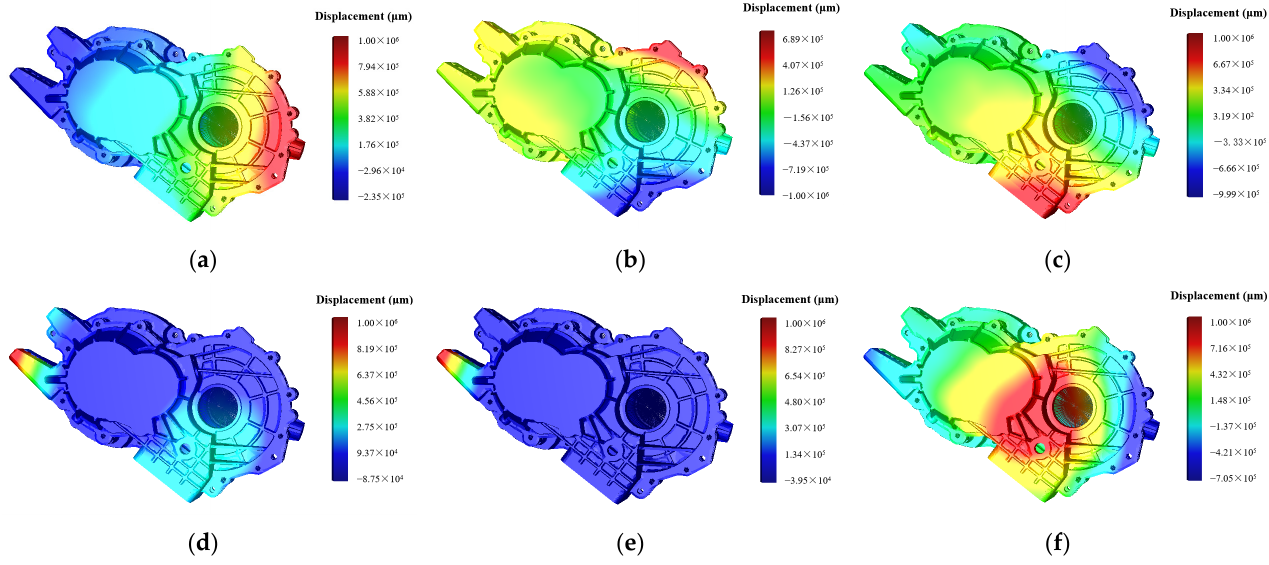
Figure 11. Modal shapes of the transmission housing under different frequencies with constraint: ( a ) 834 Hz; ( b ) 840 Hz; ( c ) 1752 Hz; ( d ) 2121 Hz; ( e ) 2524 Hz; ( f ) 2588 Hz. Different torques of 90, 75, and 60 Nm and three working conditions with the same torque of 60 Nm, and different speeds of 2400, 2700, and 3000 rpm were selected to solve the simulation model and were compared with the test data. The results are shown in Figures 12 and 13.